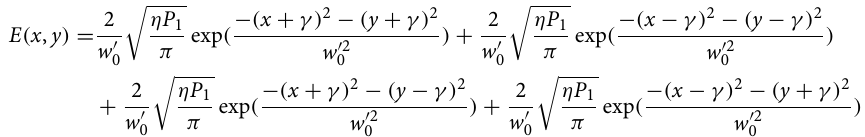
0.93 m driven by 100 GW uni-modal laser beam, subject to 0.8 m and F 0 = = 10 cm with respect to the incident multi-modal beam. ( b ) depicts the same = 5 ◦ with respect to the upright position. Generated by =